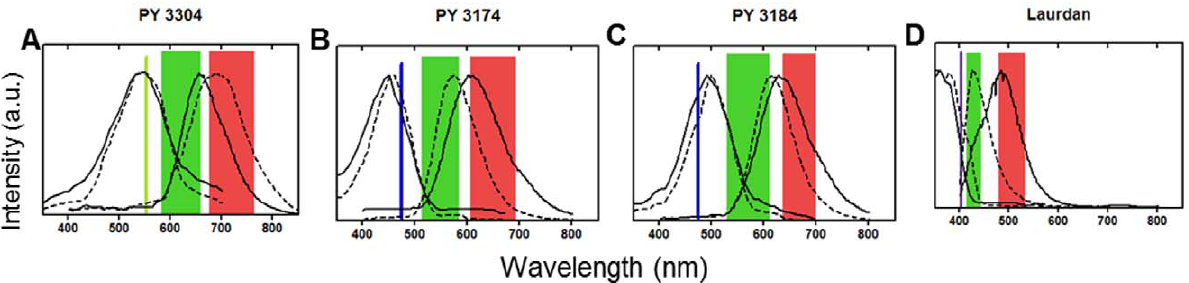
Figure 2. Excitation and emission spectra of artificial bilayers. The wavelength bands for 2-channel acquisitions are indicated by shaded boxes. Dashed line corresponds to liquid ordered phase and continuous line corresponds to liquid disordered phase. The solid vertical line corresponds to the excitation wavelength used for microscopy experiments.